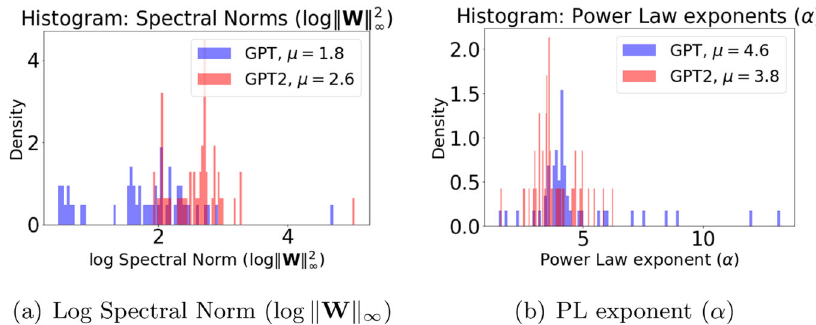
Fig. 6 Histogram of PL exponents and Log Spectral Norms for NLP models. Histogram of Log Spectral Norms (in a ) and PL exponents (in b ) for weight matrices from the OpenAI GPT and GPT2-small pretrained models.